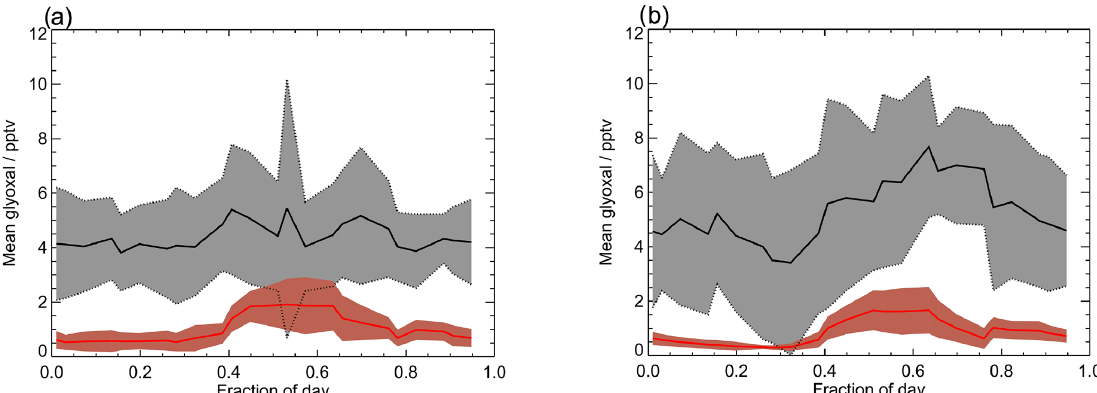
Figure 9. Average observed (black) and modelled (red) glyoxal diurnal profiles for (a) the first measurement period and (b) the second measurement period for the base model run. Shaded regions show the 1 σ variability of the data. Note that the diurnal profiles only include data for which supporting measurements required to run the model are available and thus show small differences from the mean diurnal profiles displayed in Fig. 6.